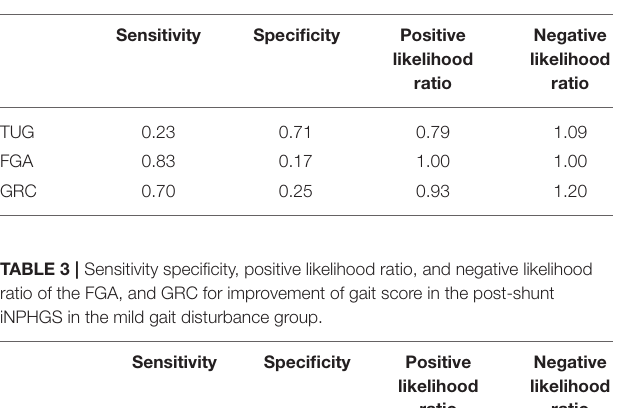
TABLE 2 | Sensitivity specificity, positive likelihood ratio, and negative likelihood ratio of the TUG, FGA, and GRC for improvement of gait score in the post-shunt iNPHGS.